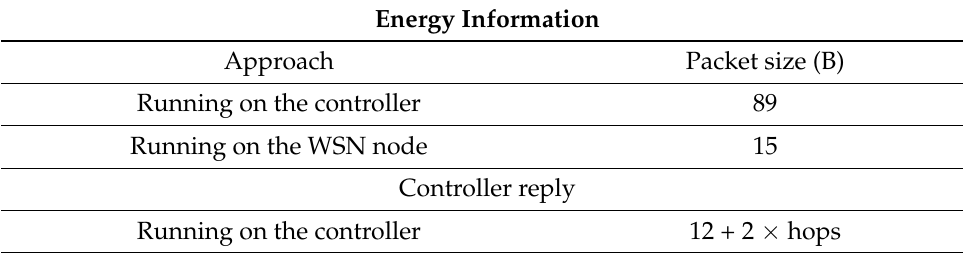
Table 2. Energy information packets’ sizes.